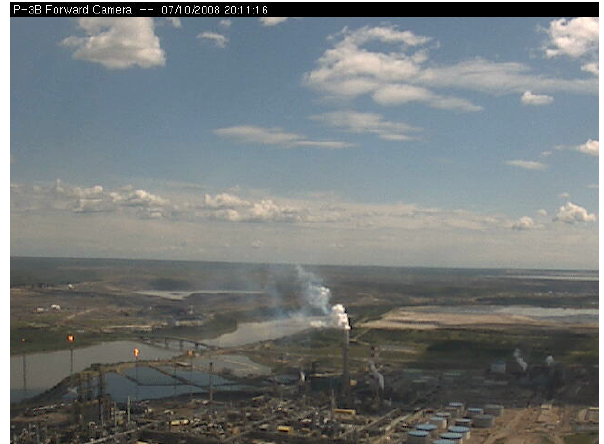
Figure 3. Flight tracks during ARCTAS that passed near the oil sands facilities. Red traces are the P-3B; DC-8 tracks are blue. Em- phasized sections are where the aircraft intercepted the